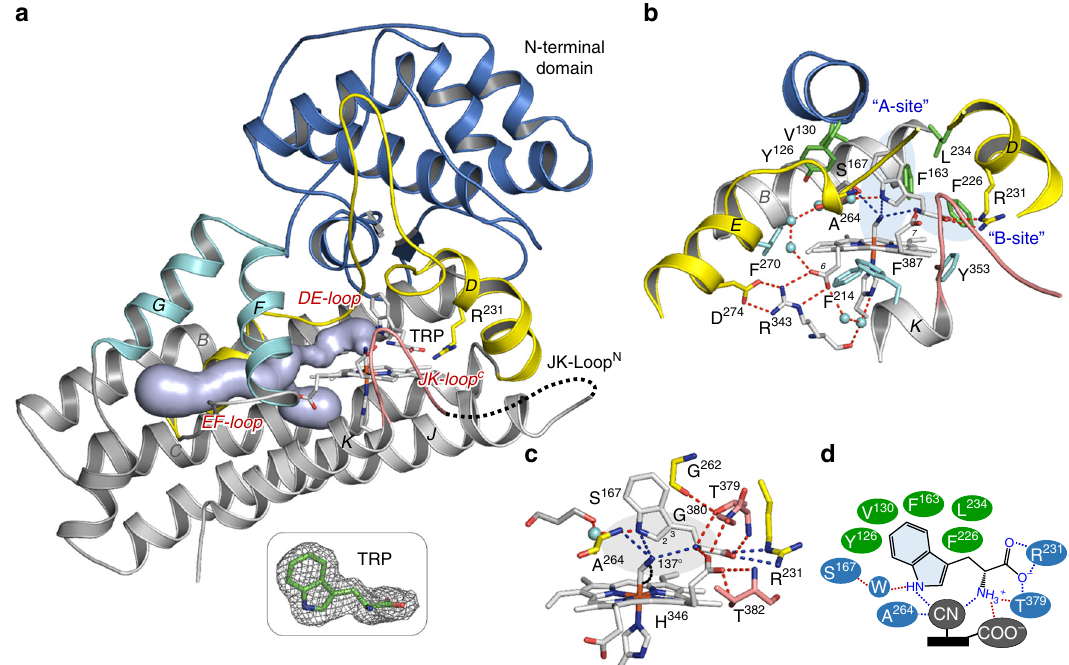
Fig. 1 Binding mode of Trp. a Crystal structure of the hIDO1-CN-Trp complex. The nomenclature of the α -helices is based on sequence alignment shown in Supplementary Fig. 1. The black dotted line indicates the disordered JK-Loop N . The tint lightblue surface illustrates an active site access tunnel that penetrates through the EF-Loop, along one side of the E-Helix, towards F270 in the E-Helix (not shown), where it bifurcates into two branches reaching out to the distal and proximal heme pockets. The tunnel is contoured with the Caver 3.02 plugin in PyMol (http://caver.cz/). The 2Fo-Fc map of the bound Trp shown in the bottom inset is contoured at 1.0 σ . b , c Blow-up views of the active site, Sa. The Trp binds in the distal heme pocket, with the indole ring occupying the A site and the carboxylate/ammonium groups occupying the B site, as highlighted in lightblue background in b . The Trp interacts with the protein matrix, as well as the heme, via various hydrophobic and polar interactions as summarized in d (see details in the main text). Together, they position the terminal atom of the diatomic ligand next to the C 2 of the Trp in an oxyanion hole, highlighted in grey background in c ; in addition, they distort the porphyrin macrocycle out of the typical planar conformation and produce an imidazolate character on H346, both of which are critical for the dioxygenase activity of the enzyme 3 . It is noted that T379 and G380 are part of the “ GTGG ” motif in the JK-Loop C , which is fully conserved in IDO1 and TDO families of enzymes (Supplementary Fig. 1), while G262 and A264 are part of the